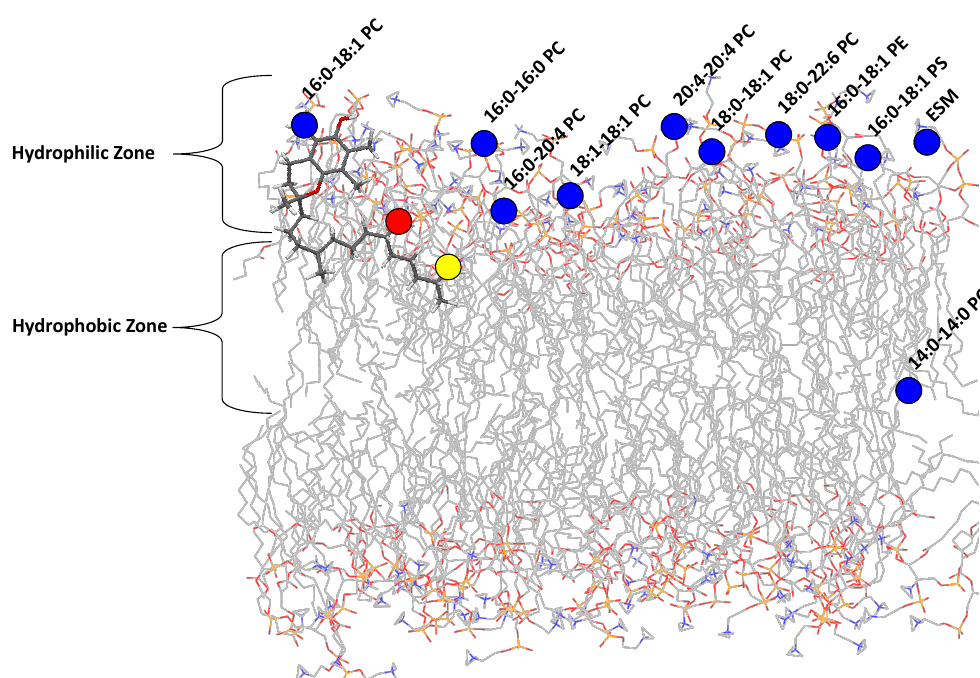
Figure 2. A representation of the locations that α -tocopherol (aToc) assumes in different phospholipid bilayers. The blue circles show the location of the aToc-C5d3 label in the vicinity of the lipid headgroups. The red circle is the location of the aToc-C5’d2 label, and the yellow is the aToc-C9’d2 label. Reproduced from [15].